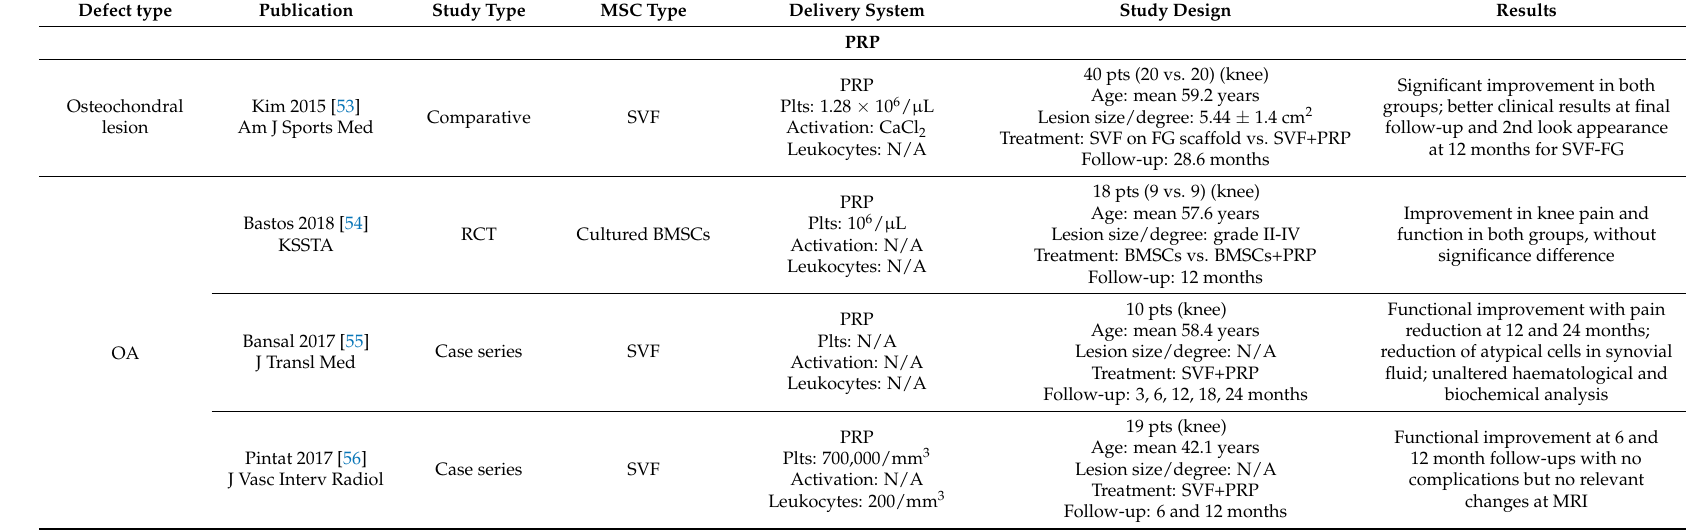
Table 2. Details of clinical papers identified in the systematic